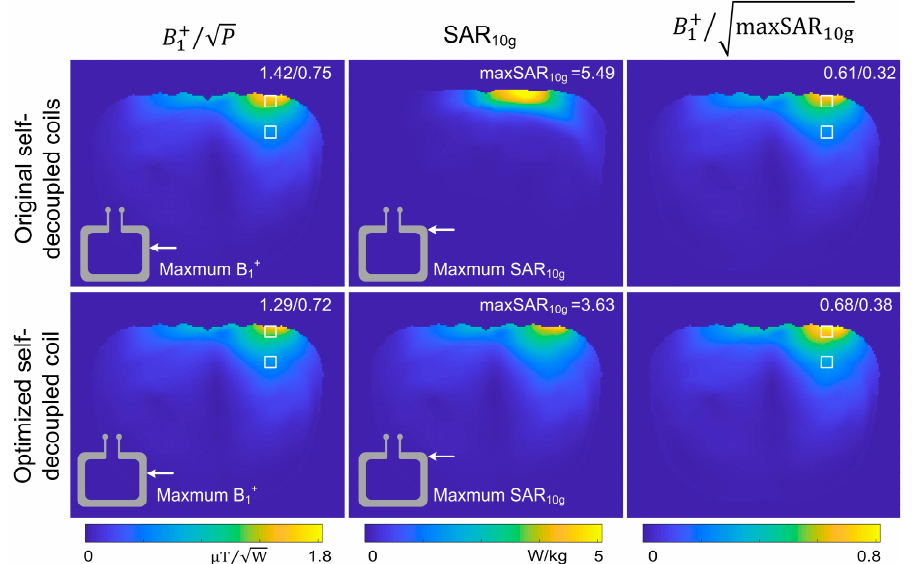
Figure 5. Comparison of simulated B 1+ efficiencies, SAR 10g , and B 1+ SAR efficiencies between original and optimized self-decoupled coils on a human body model.